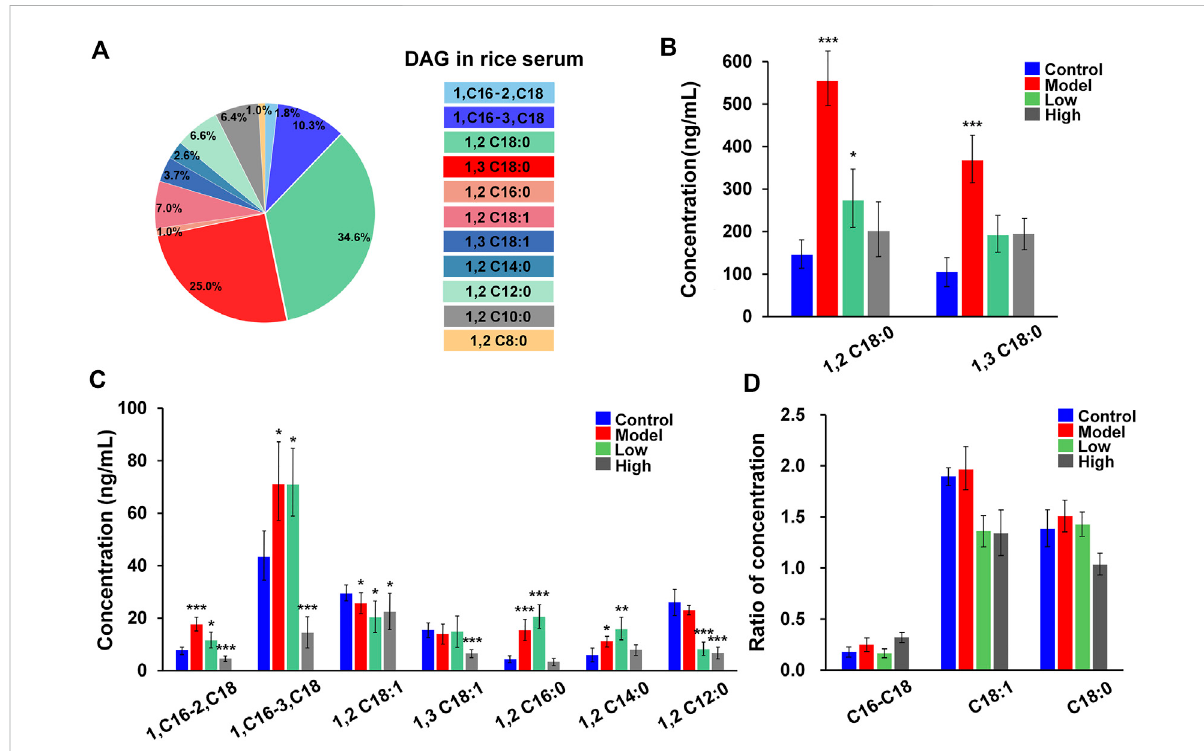
intensity changes of DAGs from four sets of samples were summarized in Figures 7B,C (normal controls, models,